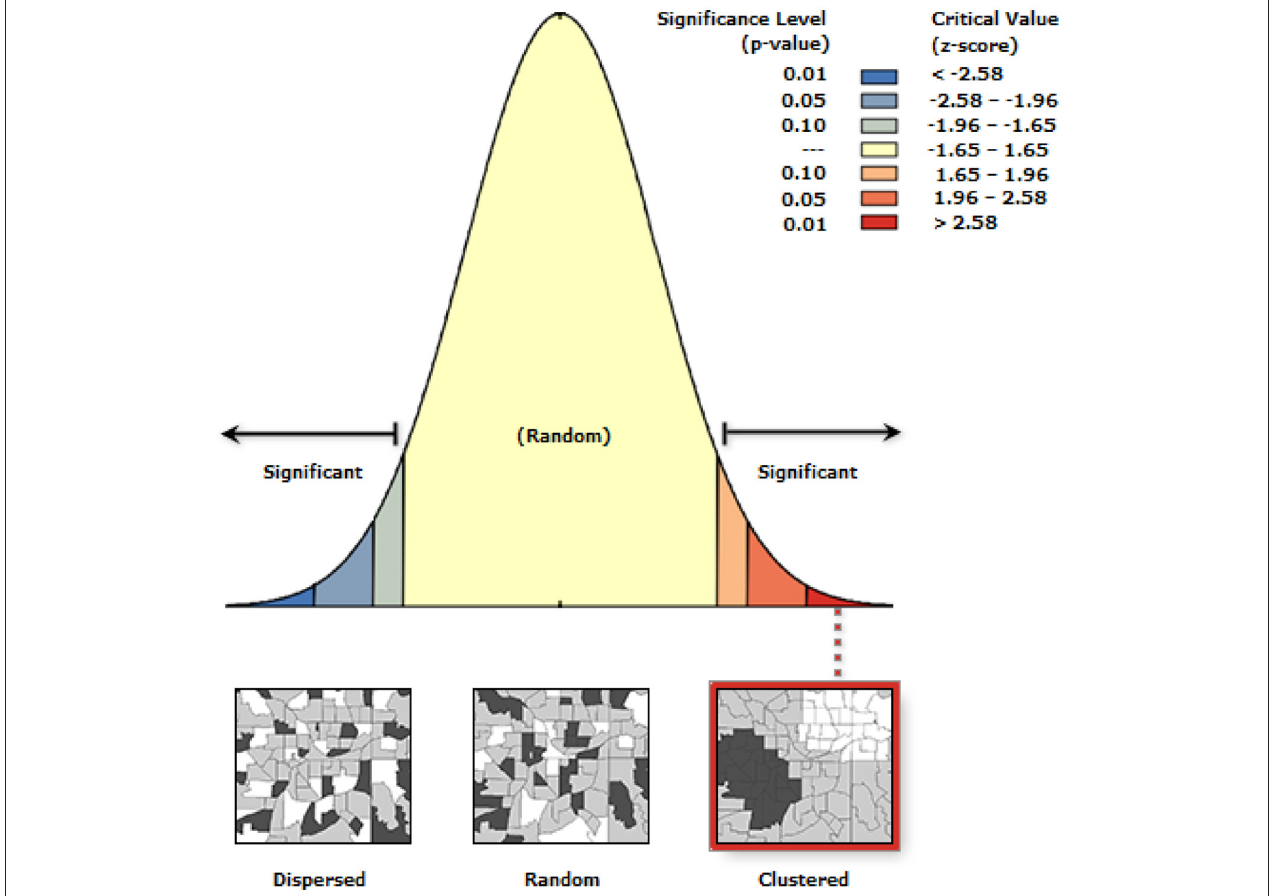
FIGURE 2 | Spatial autocorrelation analysis of risky health behavior among males in Ethiopia, 2016.